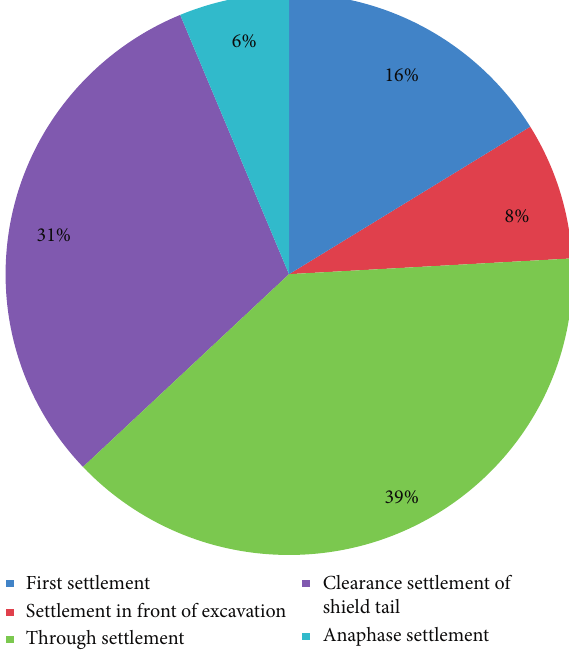
Figure 15: Settlement scale map of cross section 2 (test